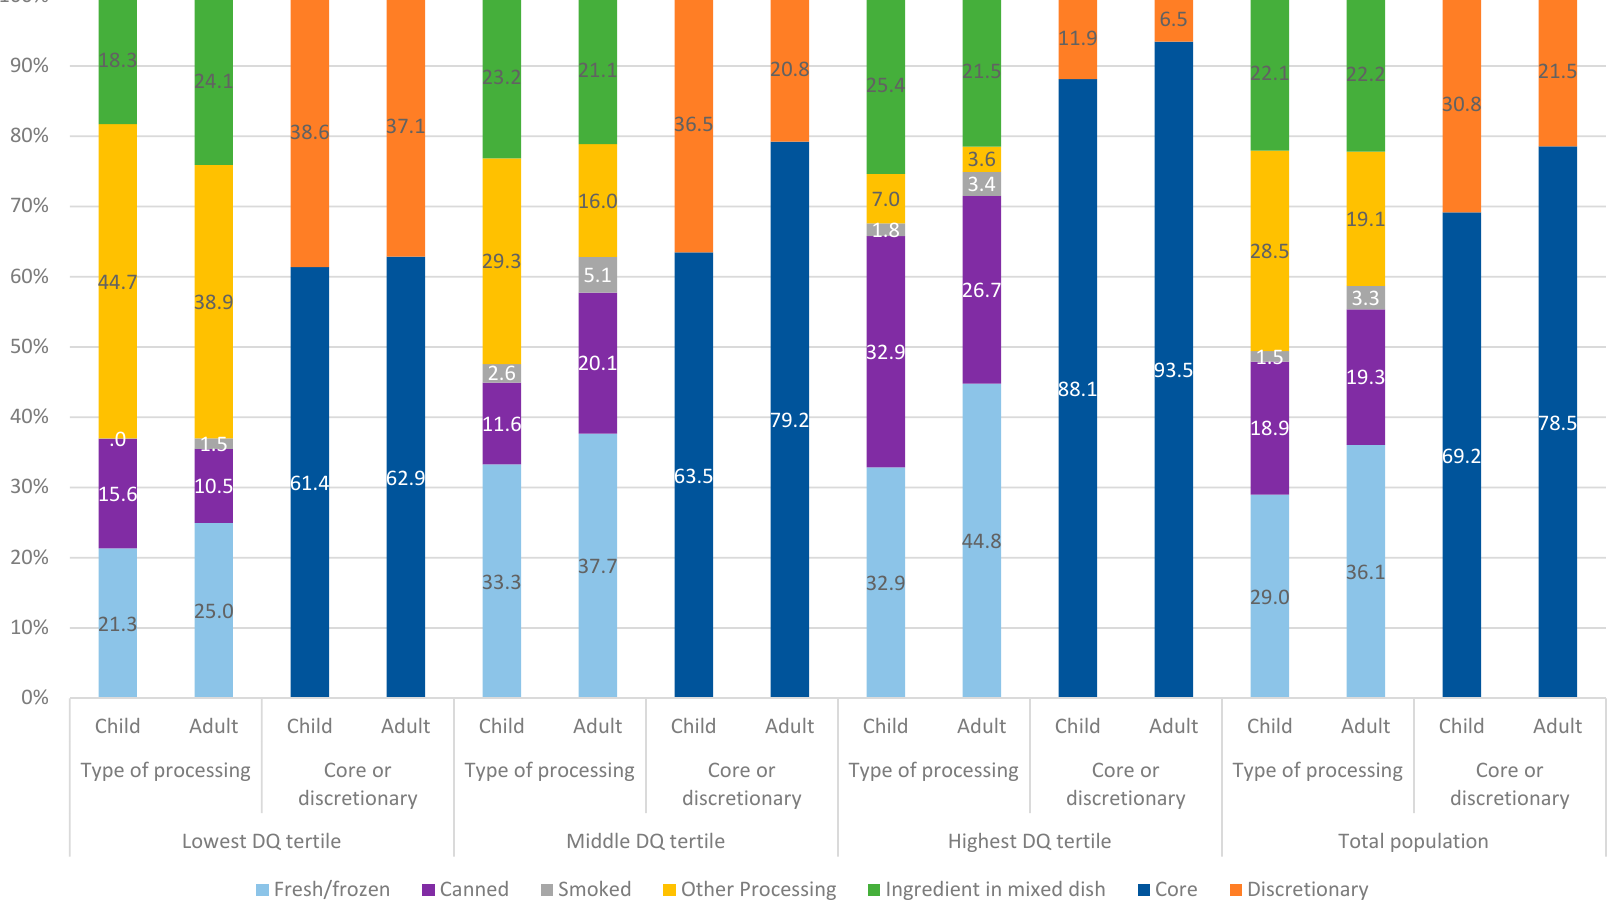
Figure 3. Proportion of total seafood consumed (among seafood consumers) according to type of processing and as core or discretionary by diet quality tertiles. DQ = diet quality.